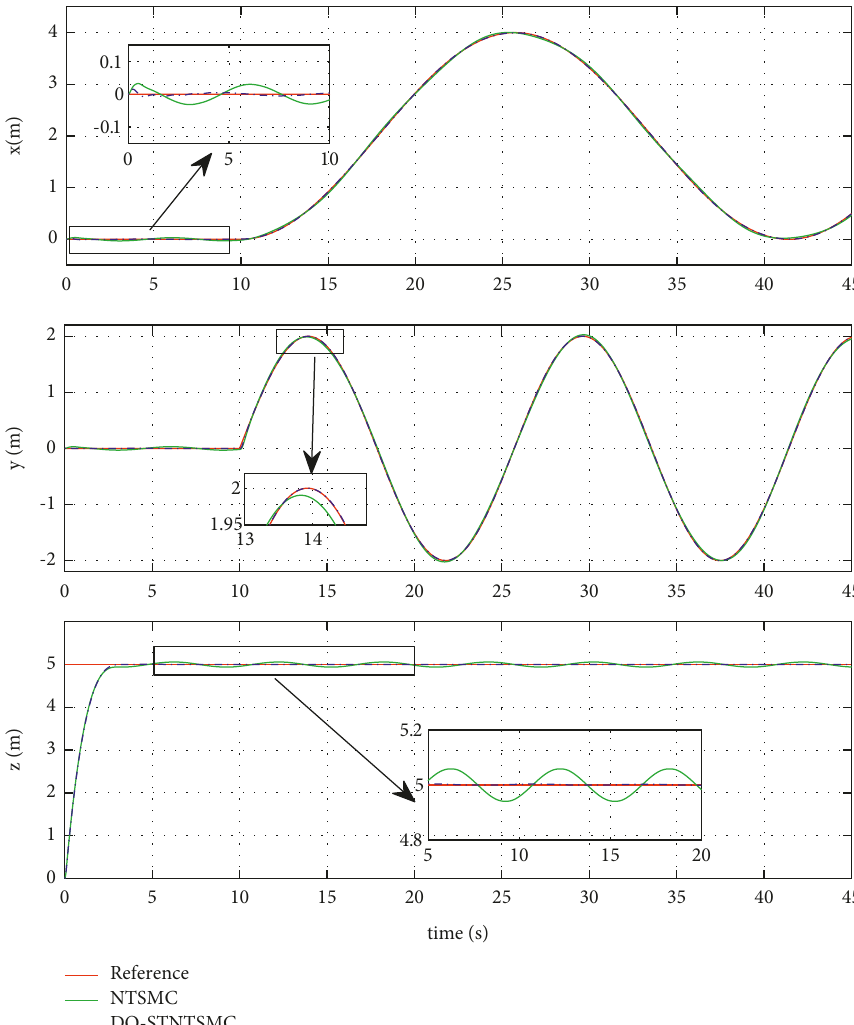
Figure 11: Response curves of the quadrotor’s position ( x,y, z ) in the second scenario.